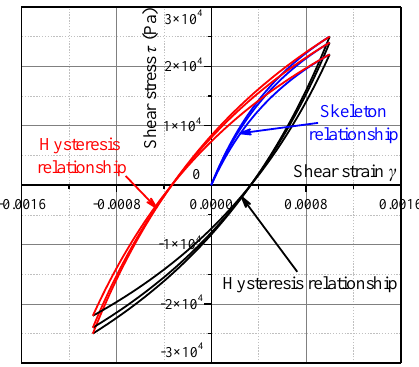
Figure 5. Dynamic shear stress–strain relationship of the Davidenkov model.